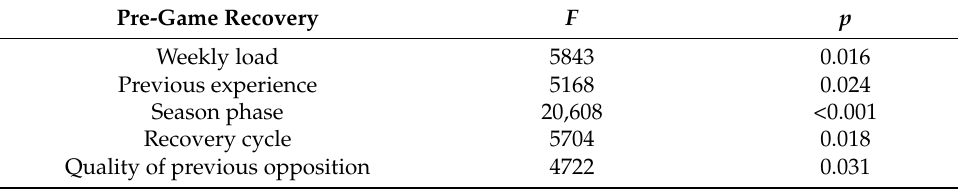
Table 4. Main significant effects on recovery.